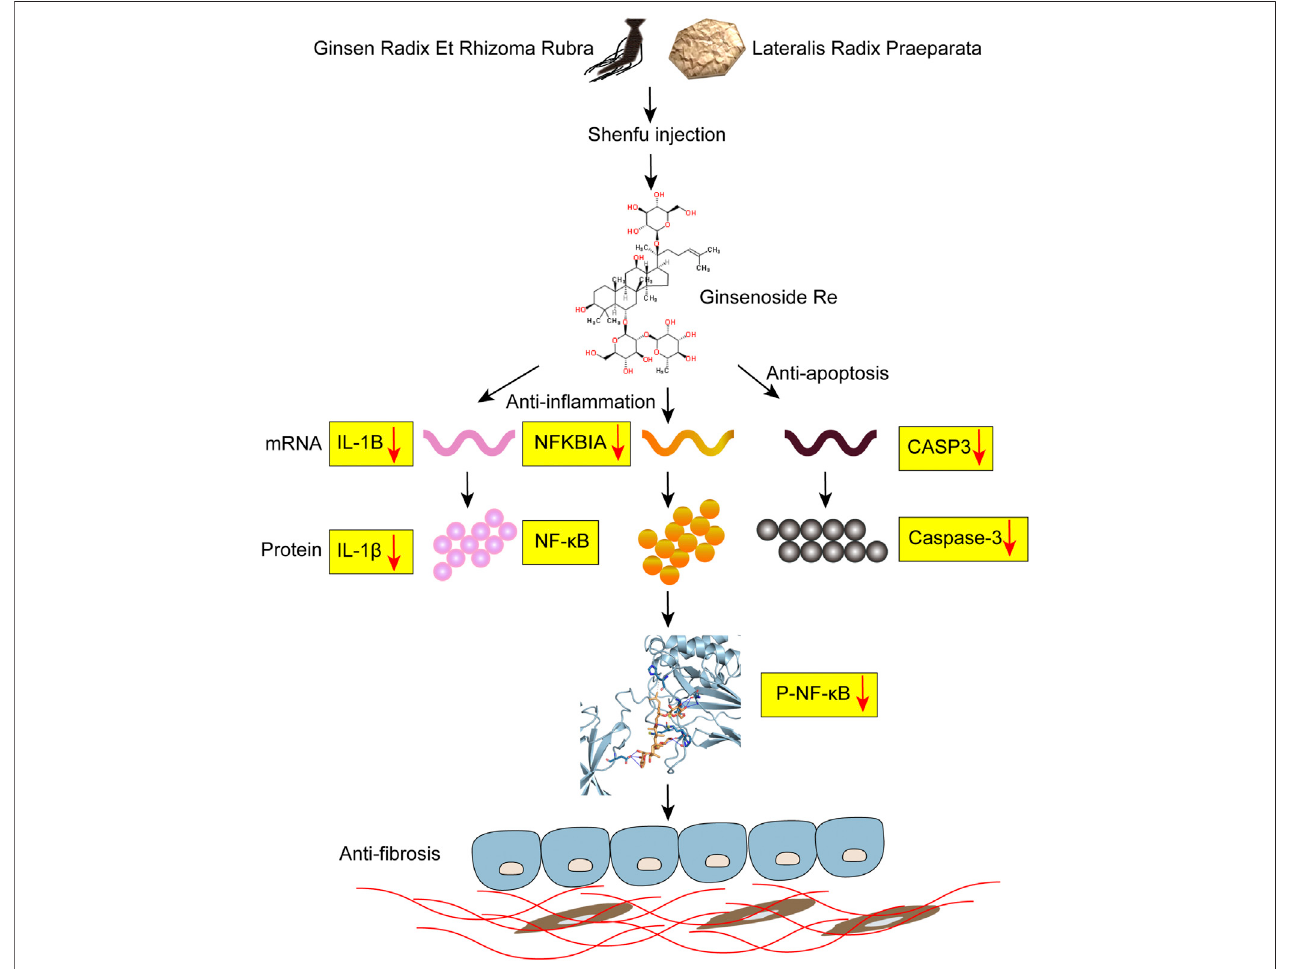
FIGURE 6 | Potential mechanism of Shenfu injection alleviating BLM-induced pulmonary fi brosis. Shenfu injection may have the function of anti-in fl ammation and anti-apoptosis by targeting NFKBIA, CASP3 and IL-1B, and alleviate BLM-induced pulmonary fi brosis.